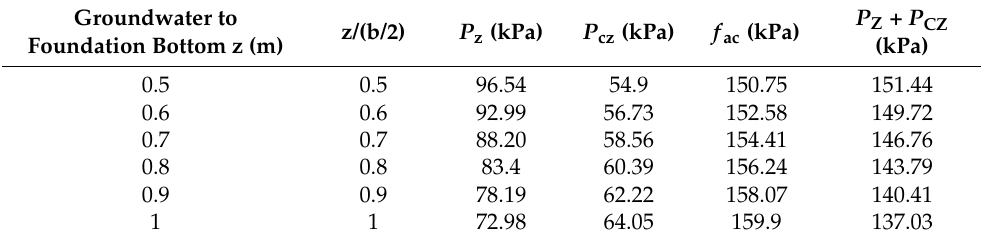
Table 7. Calculation results of foundation bearing capacity (b = 2.0 m, d = 2.5 m).